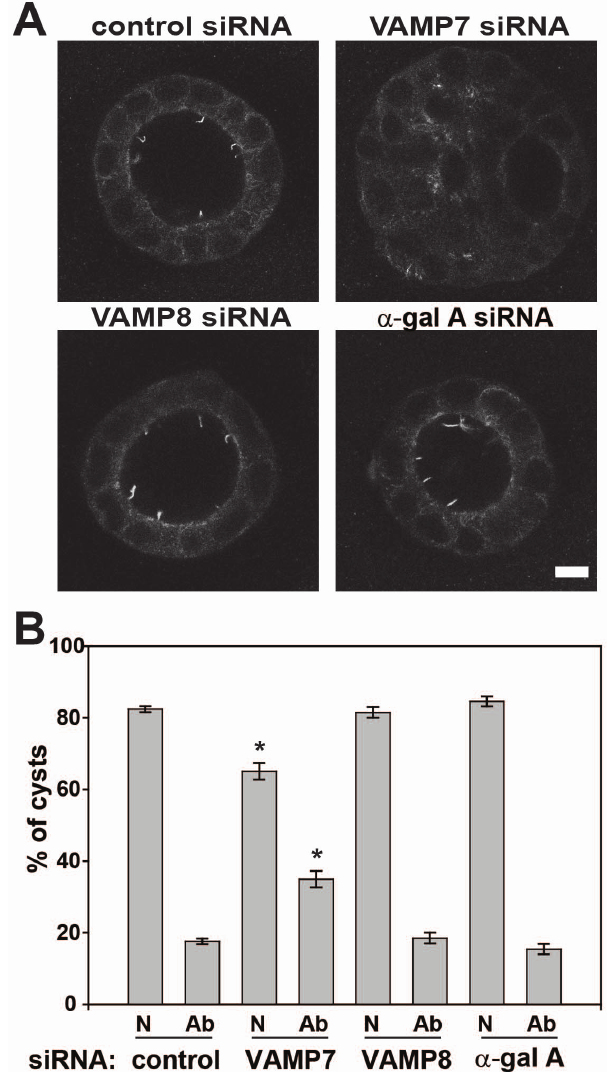
Figure 7. VAMP7 knockdown disrupts cyst morphology. MDCK cells were transfected with control, VAMP7, VAMP8 or a -gal A siRNA as indicated, then trypsinized and resuspended in basement membrane matrix the following day. Six days later, the cells were fixed and processed for immunofluorescence with anti-acetylated tubulin anti- body to detect cilia. Confocal imaging revealed normal hollow lumens and cells with cilia projecting into the lumen in control, VAMP8 or a -gal A siRNA treated cells. However, transfection with VAMP7 siRNA led to an increase in the fraction of abnormal cysts with either filled lumens or multiple lumens. (A) Representative examples of a normal cyst in control siRNA-treated cells and an abnormal cyst in a VAMP7 siRNA treated sample are shown. (B) One hundred cysts from each siRNA treatment were classified as normal (N) or abnormal (Ab) in three experiments. *p , 0.001 using one-way ANOVA with Bonferroni correction.